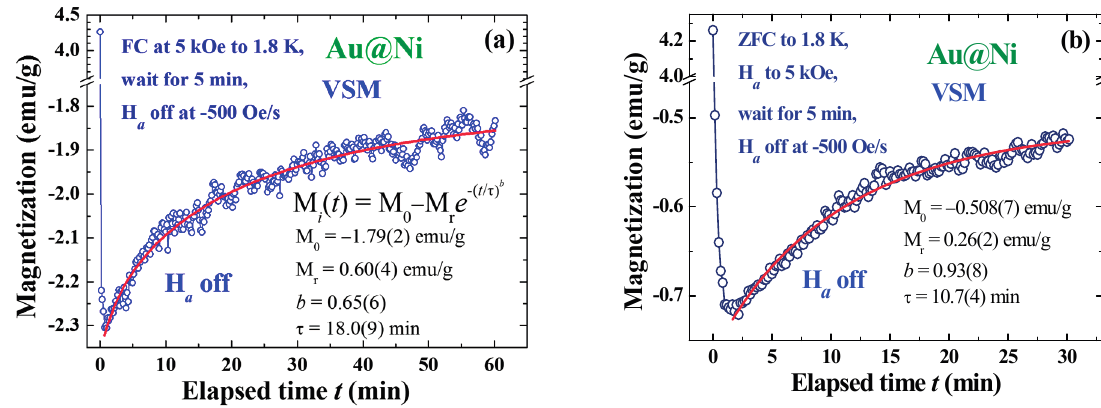
Figure 5. ( a ) Temporal evolution of the induced magnetization recorded after field-cooling at H a = 5 kOe from 300 to 1.8 K, followed by a wait time of 5 min before turning the H a off at a rate of − 500 Oe/s; and ( b ) temporal evolution of the induced magnetization recorded after zero-field-cooling from 300 to 1.8 K, followed by turning the H a on to 5 kOe and waiting for 5 min before turning H a off at a rate of R H = − 500